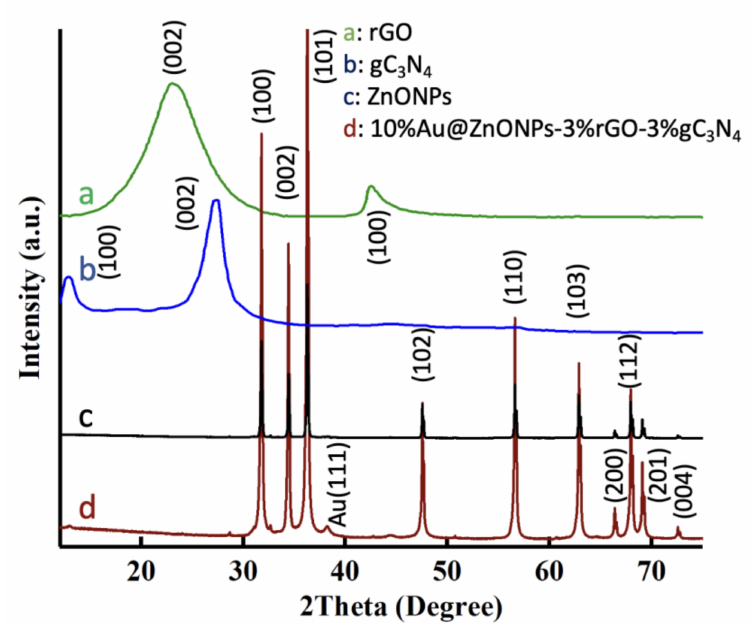
Figure 3. ( a ) XRD patterns of rGO; ( b ) gC 3 N 4 ; ( c ) ZnONPs; and ( d ) 10%Au@ZnONPs-3%rGO- 3%gC 3 N 4